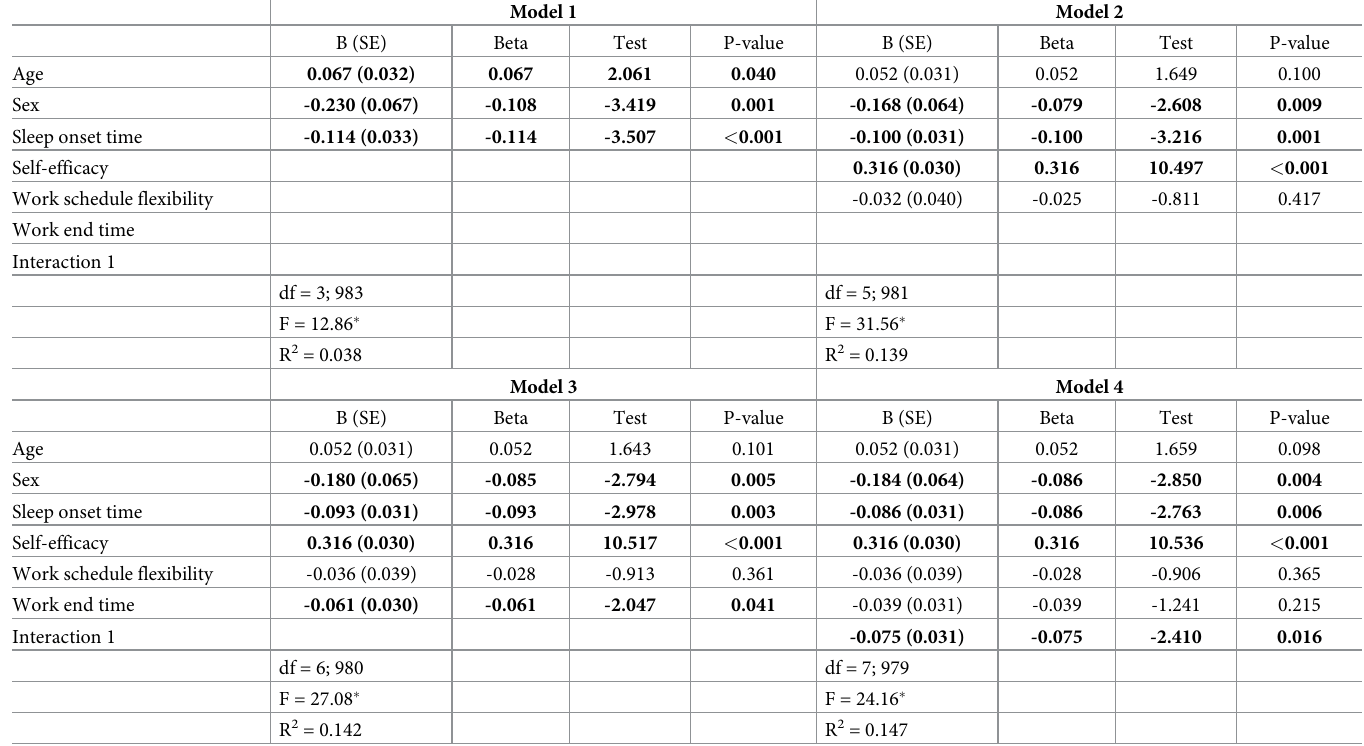
Table 3. Summary of hierarchical regression analysis for variables and interactions predicting psychological well-being score (n =